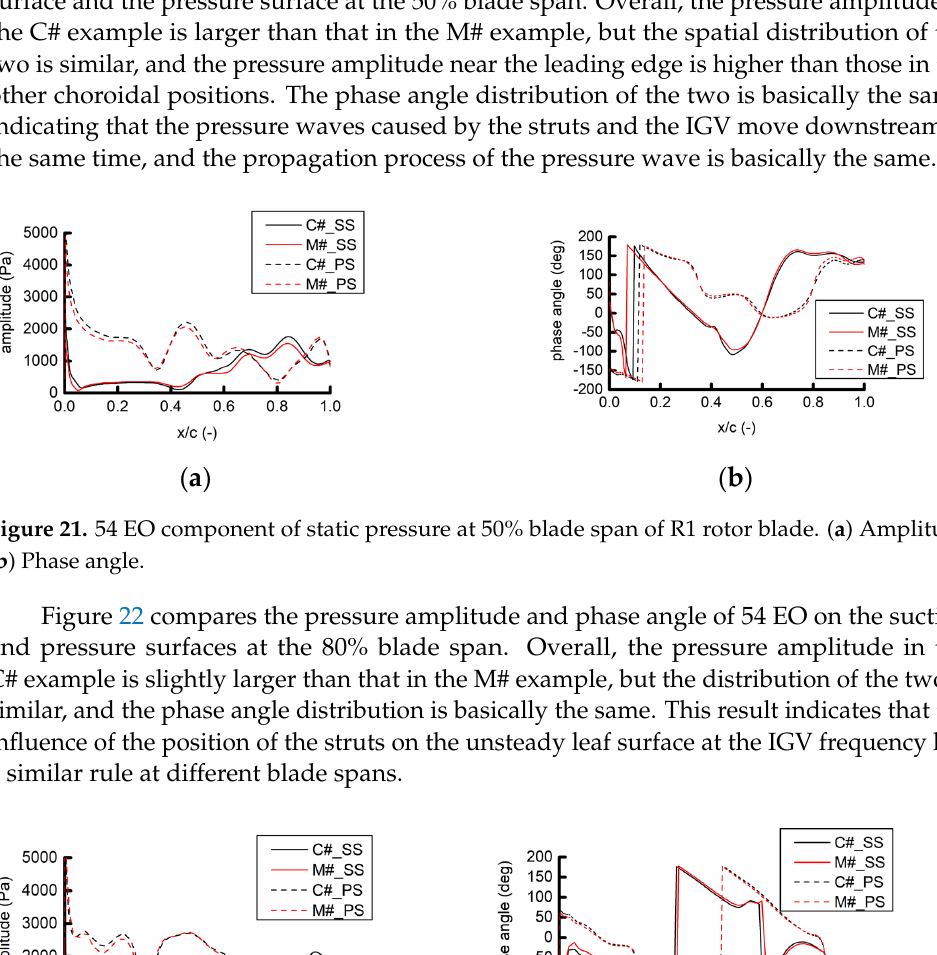
Figure 20. 54 EO amplitude of static pressure on the surface of R1 rotor blade (red line is shock wave). ( a ) C# ( b ) M#.